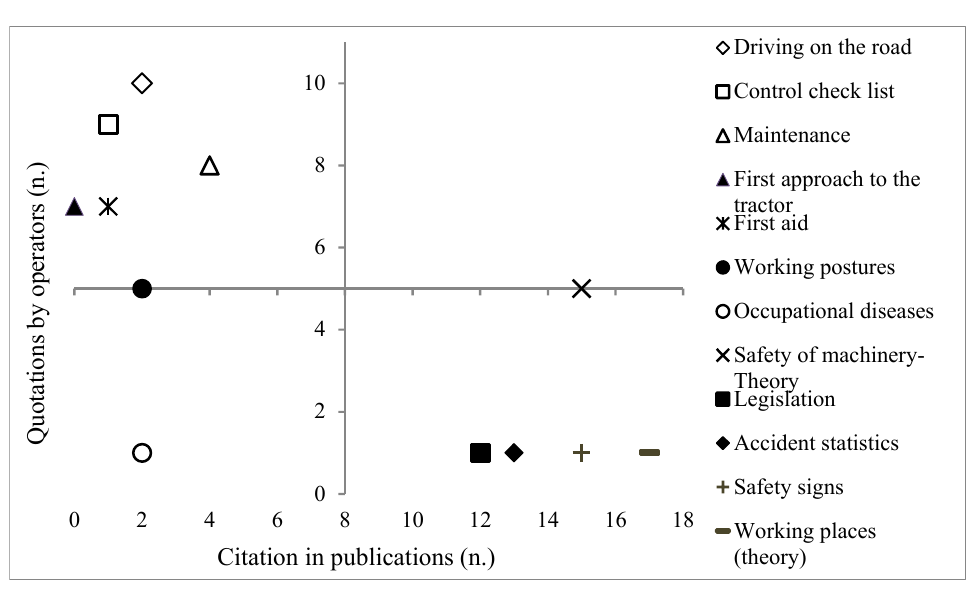
Figure 1. The x ‐ axis shows the topics dealt with in the publications, the y ‐ axis shows the topics quoted Figure 1. The x -axis shows the topics dealt with in the publications, the y -axis shows the topics quoted by the operators. by the